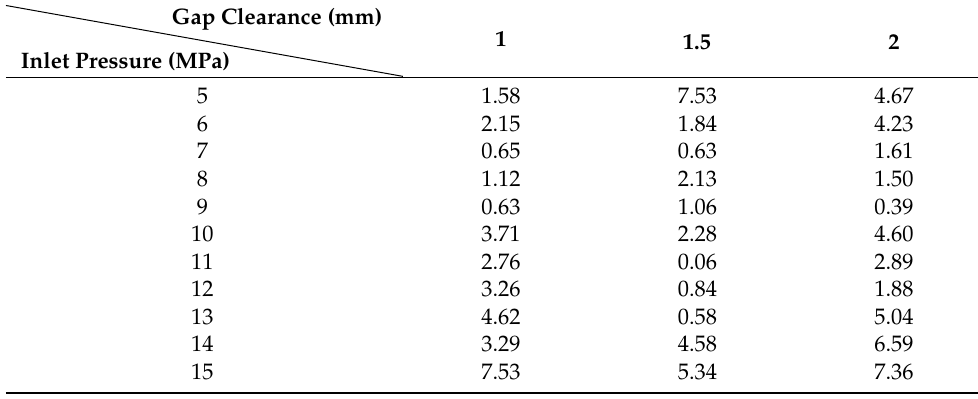
Table 5. Relative errors (%) for suction cup- θ